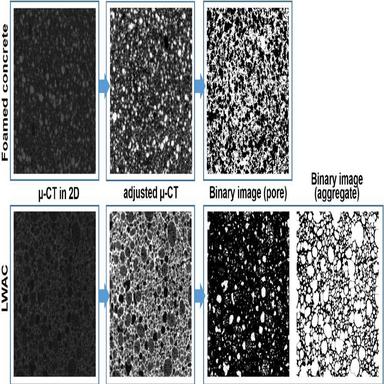
l-CT imaging of foamed concrete and LWAC (Note: the 1st figures in each material are 8-bit CT images, while the 2nd figures have been adjusted to enhance the contrast. The other images are the segmented images of pores and aggregates. In the binary pore image (3rd), the white represents pores, while the black represents the background. The white region in the aggregate binary image (4th in LWAC) represents aggregate solids.).